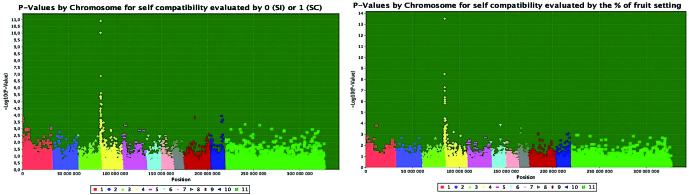
Genome-wide association study (GWAS) of self-incompatibility traits. GWAS-derived Manhattan plots showing significant P-values associated with self-incompatibility traits. Left: a qualitative variable was used with a score of 0 for self-incompatible trees (less than 10% of fruit setting after self-pollination) and 1 for self-compatible trees (more than 30% of fruit setting after self-pollination). Right: a quantitative variable: the percentage of fruit setting, assessed 14 d after self-pollination. A total of 16 480 genome-wide SNP markers identified by GBS were used for this analysis to generate the data, which was analysed using the MLM procedure of the Tassel software. Significant associations for CH1 to CH10, and for unmapped SNP (11) are shown by dots for a threshold of P-values <3e–5 [or −log10(P-value)>5.3], corresponding to a FDR cut-off q-value <0.05.